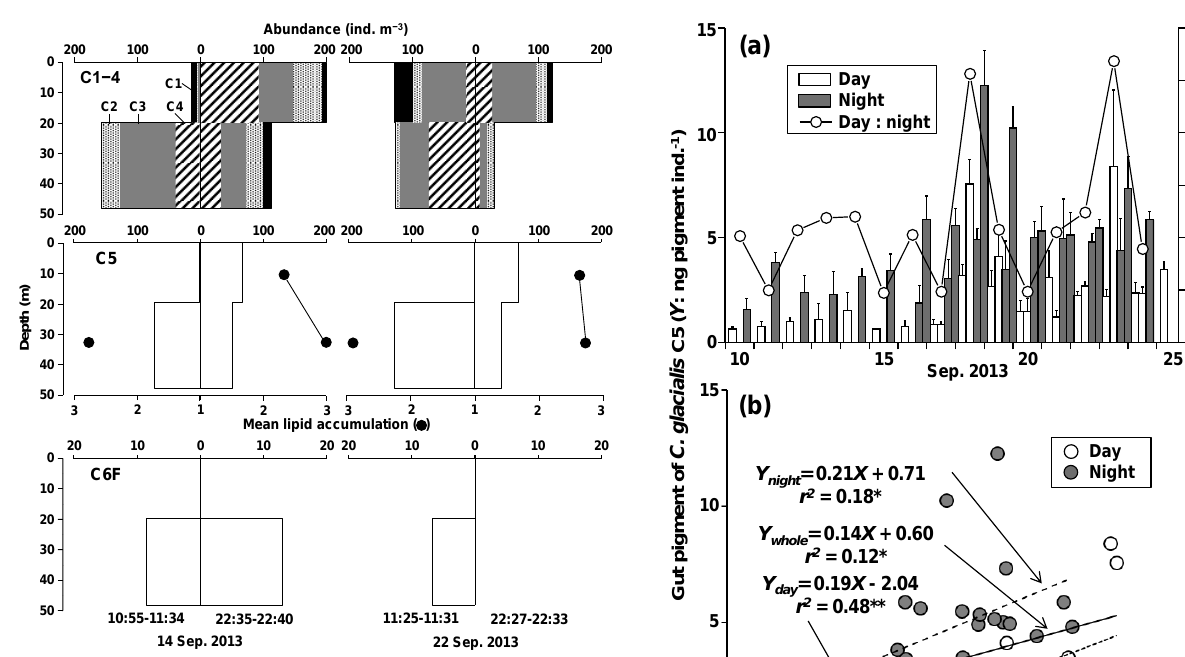
Figure 4. Diel vertical distribution of Calanus glacialis at a fixed station in the Chukchi Sea, 14 and 22 September 2013. For C5, the mean lipid accumulation score (1–3) is also shown. Note that no C6Ms were collected.